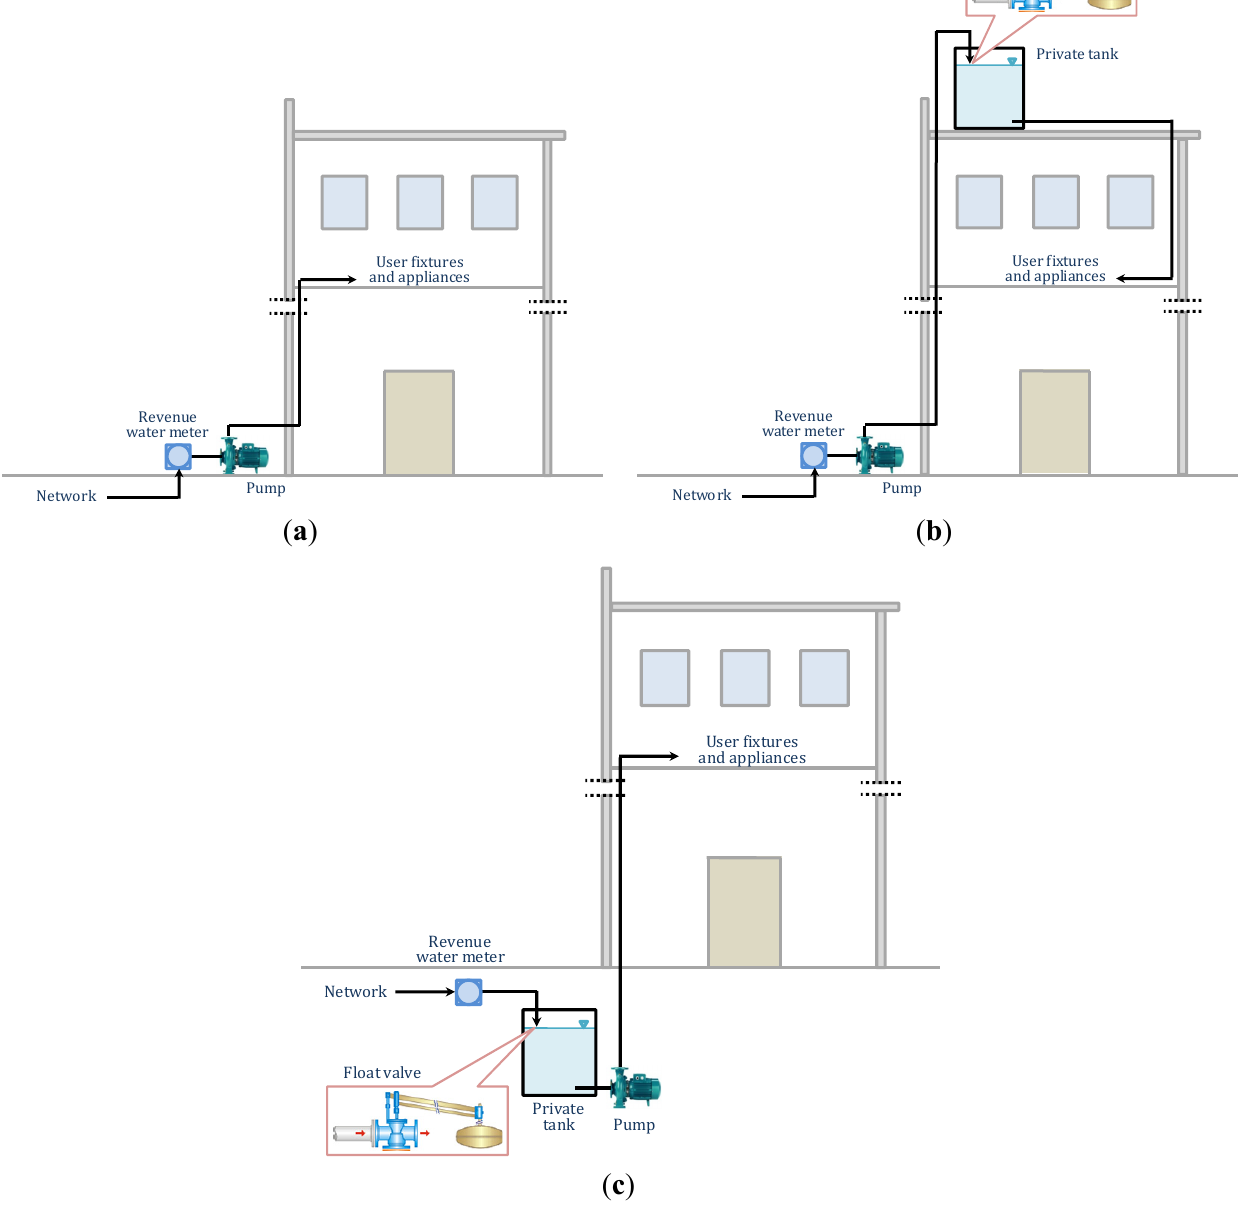
Figure 1. A schematic of the typical plumbing connection to: ( a ) the network provided with pump; ( b ) the rooftop tank; ( c ) the underground